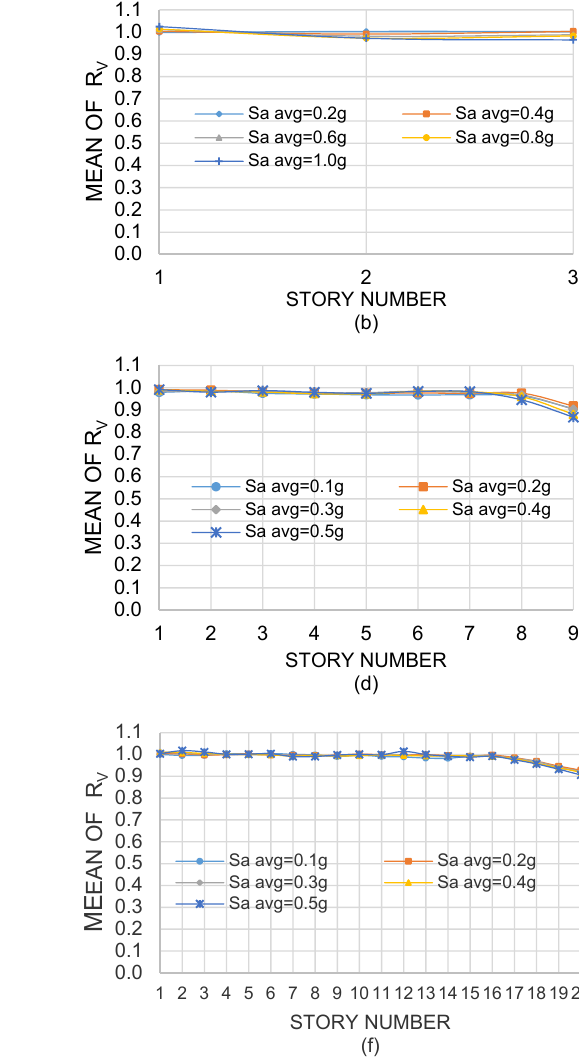
Figure 6. Values of R V ; Model 1; ( a , c , e ), Sa avg = 0.2, 0.6, 0.8 g, respectively, NS direction; ( b , d , f ) , Sa avg = 0.2, 0.6, 0.8 g, respectively, EW direction.